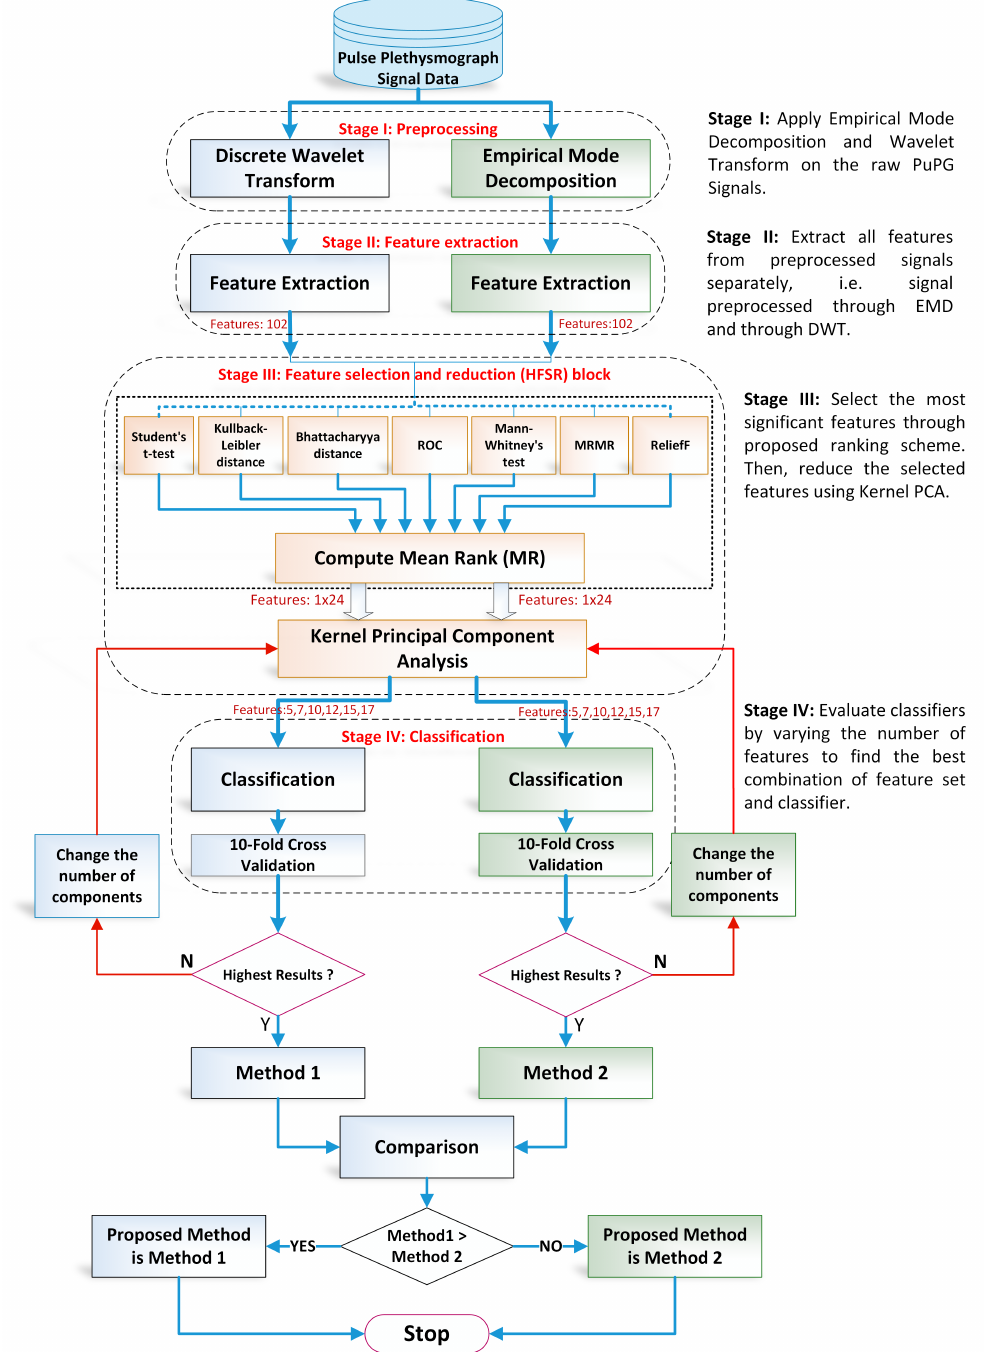
Figure 3. Overall flow chart of the proposed design methodology for detection of hypertension through pulse plethysmograph